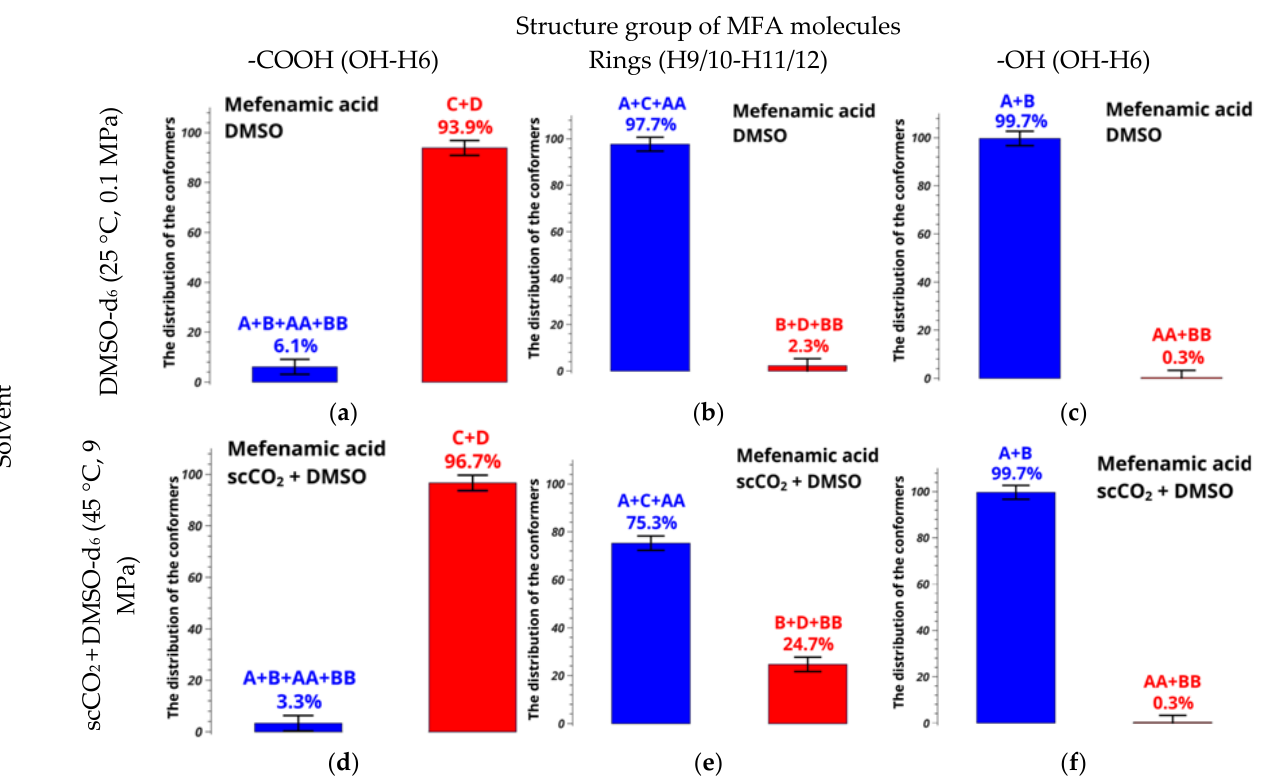
Figure 11. Relative conformer group fractions of MFA in ( a – c ) DMSO-d 6 and ( d – f ) scCO 2 + DMSO at supercritical parameters of state, calculated from experimentally found distances OH-H6 and H9/10-H11/12.